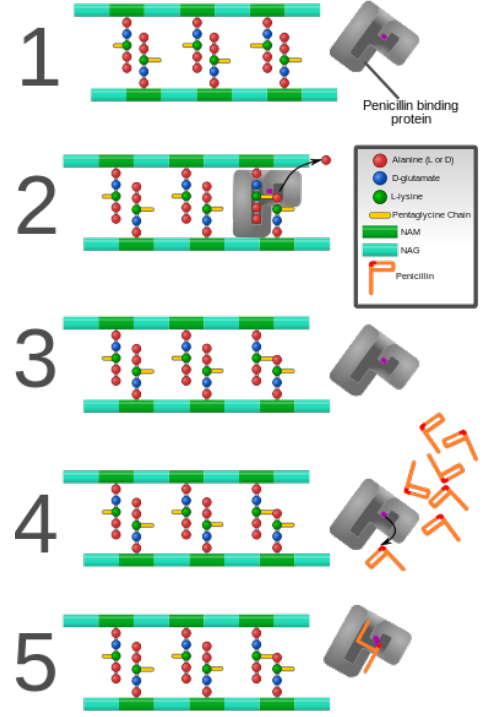
Figure 3. Penicillin and penicillin-binding protein of the bacterial cell wall. ( 1 ) The peptidoglycan layer of a bacterial cell wall harbors the repeating moieties of N -acetylglucosamine (NAG) and N -acetylmuramic acid (NAM). The NAM subunits bind short variable peptide chains, usually L -Ala and two distal D -Ala residues. ( 2 ) The PBP cross-links the peptide side chain, releasing a free Ala. ( 3 ) Upon cross-linking, the PBP dissociates from the cell wall. ( 4 ) Penicillin binds the PBP active site, affecting its enzyme activity. ( 5 ) The β-lactam ring of penicillin is cleaved during its reaction with PBP. Penicillin stays covalently bound PBP, permanently inhibiting the active site. Altered PBPs, such as PBP2a, are unable to accommodate penicillin-binding, preventing cell wall synthesis inhibition [48,49].